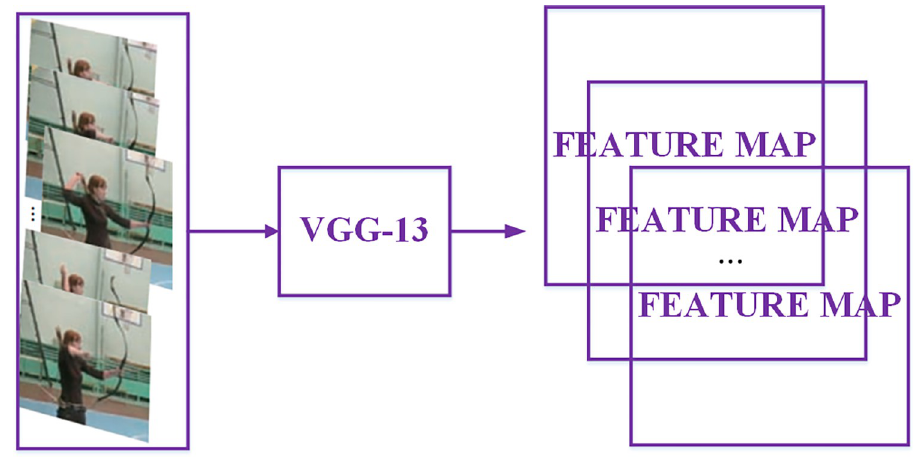
Fig 3. The feature extraction